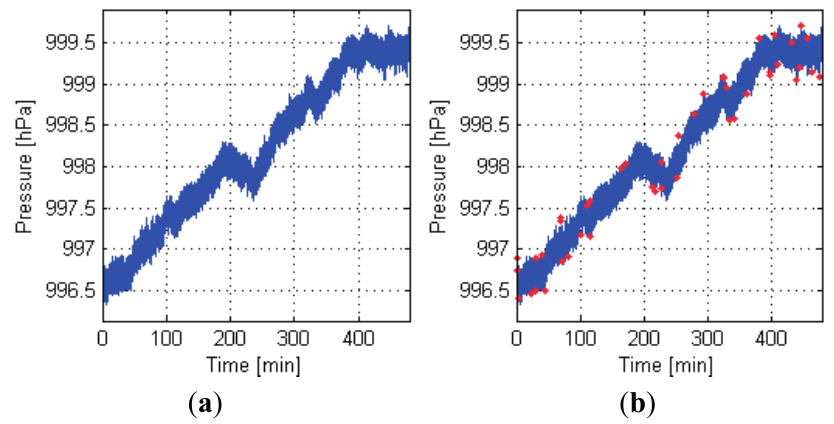
Figure 8. Treatment of the measurements from SIII with LPS331AP. ( a ) Raw data; ( b ) Results when outliers were excluded.